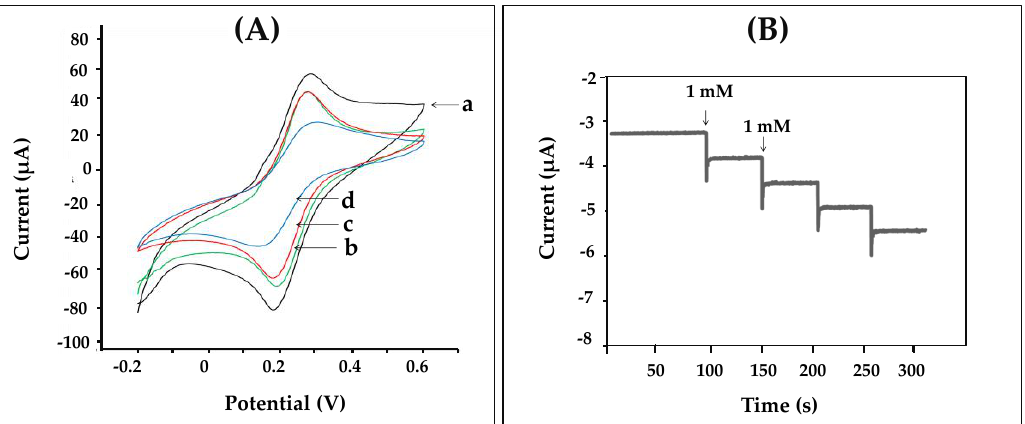
Figure 3. ( A ) Cyclic voltammograms obtained from different modified electrodes (a) bare, (b) nanofibers, (c) glutaraldehyde, and (d) HRP in 10 mM K 3 Fe(CN) 6 /K 4 Fe(CN) 6 containing 0.1 M KCl at a scan rate of 50 mV s −1 ; ( B ) shows the amperometric responses obtained from nanofibers-modified electrodes to successive addition of 1 mM hydrogen peroxide in phosphate buffer at the applied potential of −0.2 V.